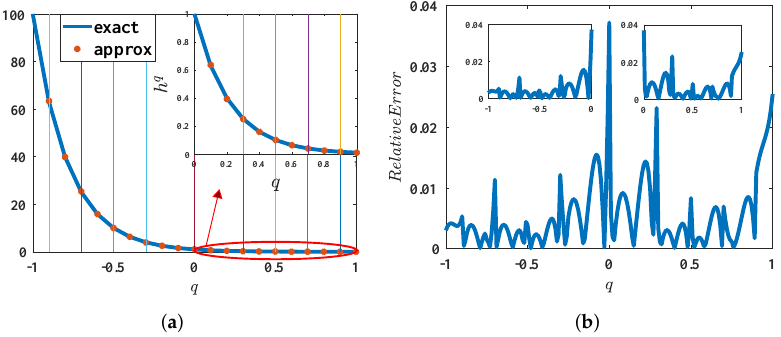
Figure 3. h q generation plots against different values of q within range [ − 1 : 1 ] . ( a ) Values of h q and ( b ) relative